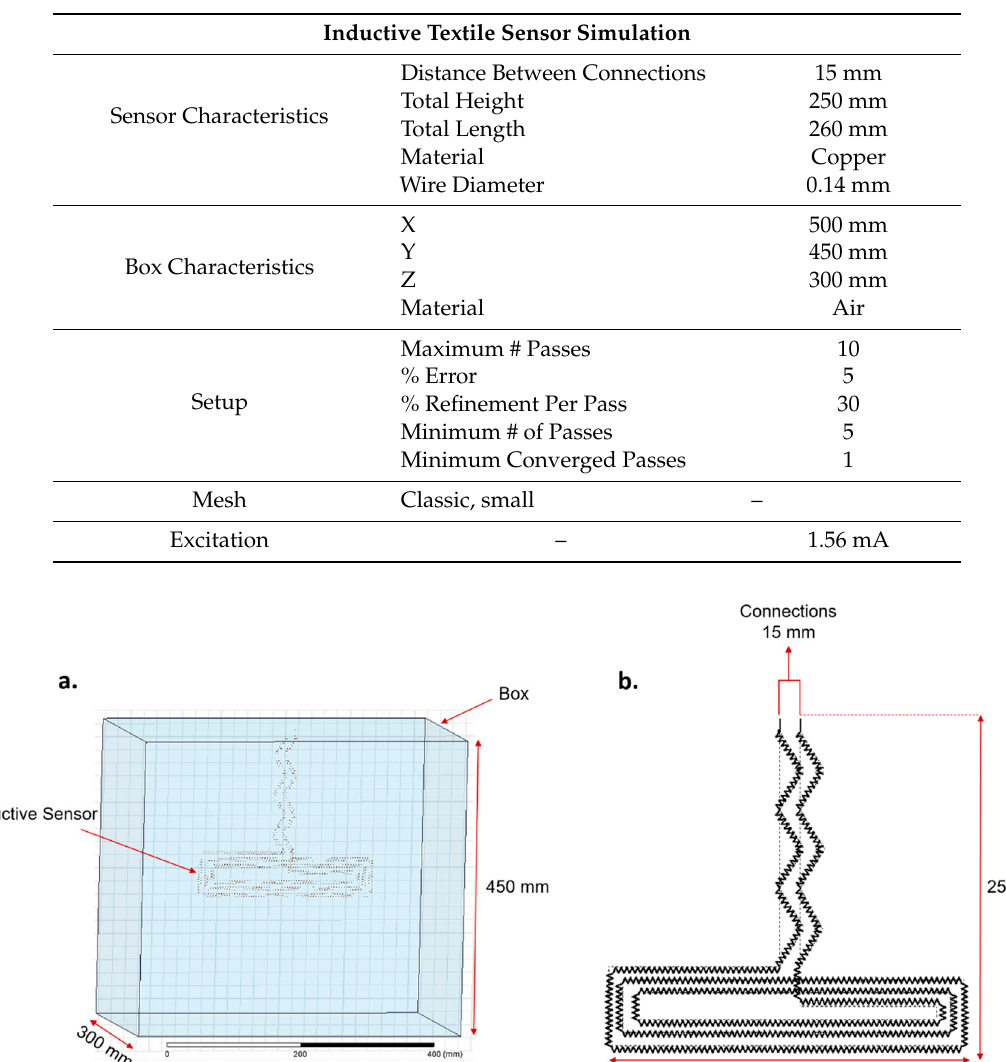
Table 2. Parameters used to simulate sensor behavior in Ansys.